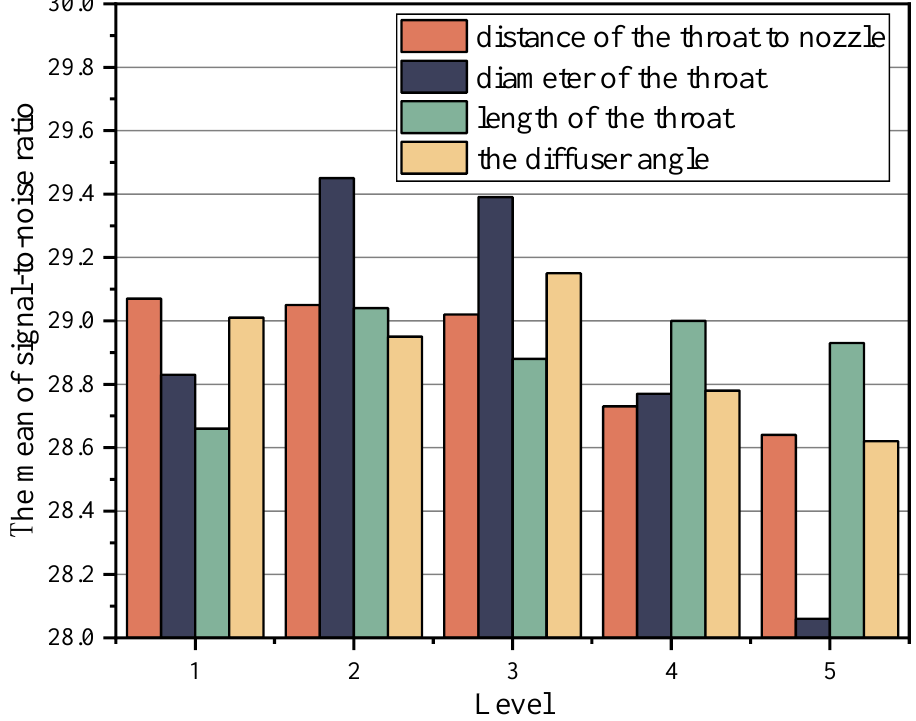
Figure 12. The main effect plot of the mean of the signal-to-noise